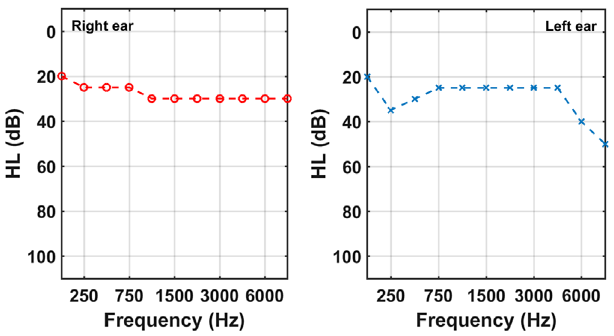
Figure 4. Right and left audiograms of a subject.